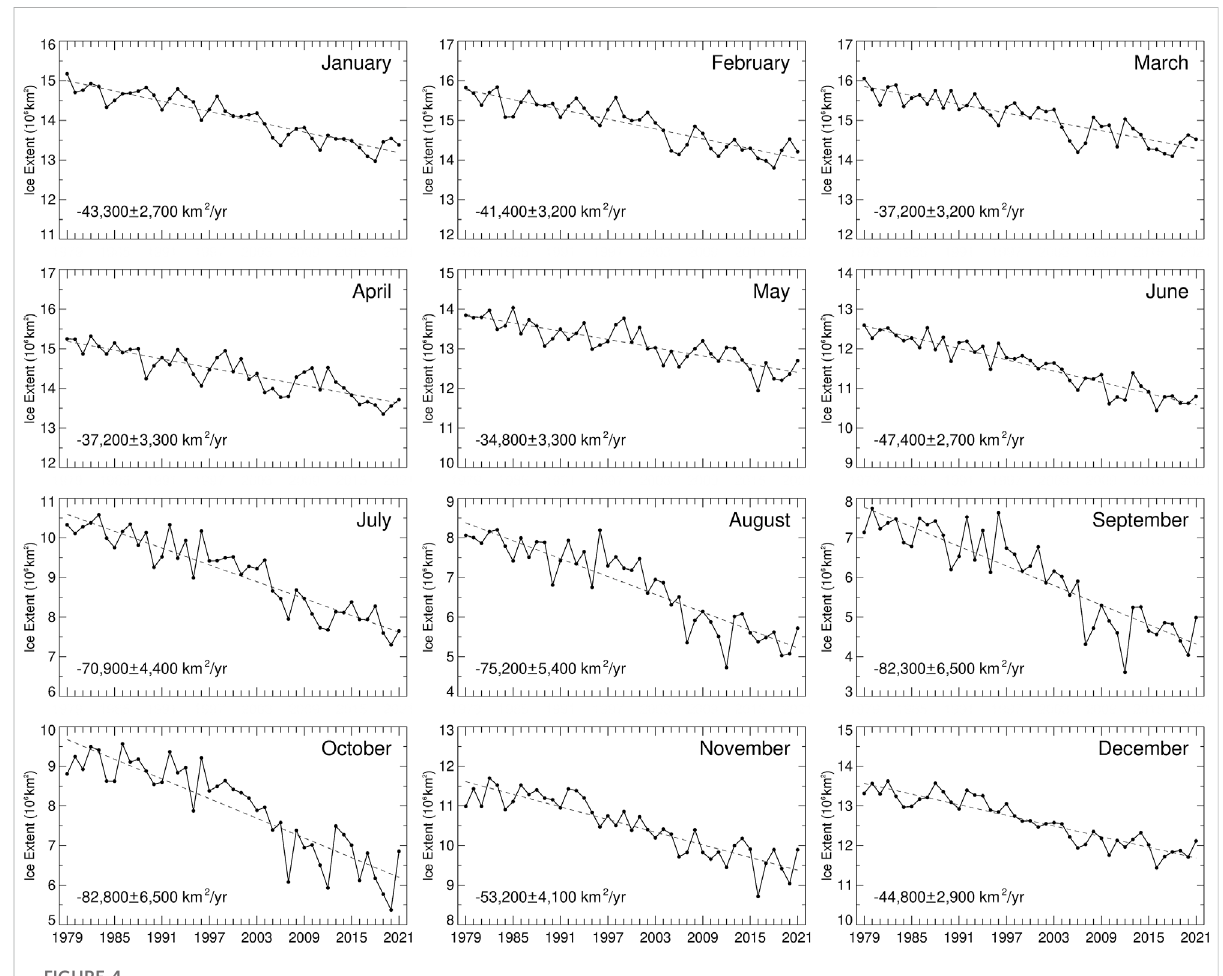
FIGURE 4 Arctic sea ice extents and trends, 1979 – 2021, for each of the 12 calendar months. The y -axis values vary for the different months, but in each case there is a range of 5 × 10 6 km 2 , to allow ready visual comparison of the trend-line